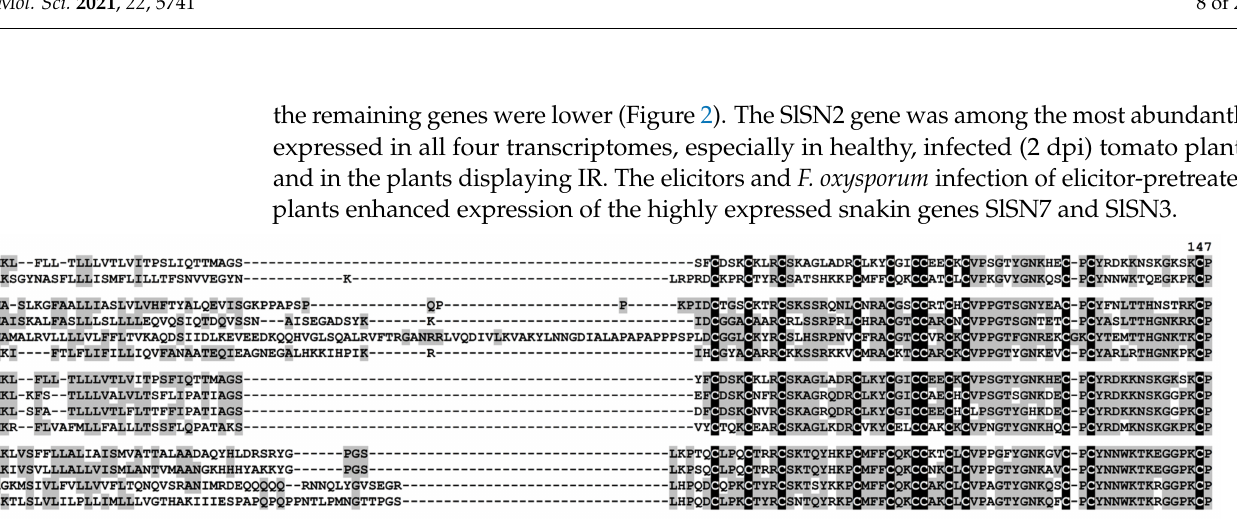
Figure 5. Multiple sequence alignment of S. lycopersicum snakin precursors and Solanum tuberosum SN1 (Q948Z4.1). Cysteine residues are shaded black, and identical amino acids are shaded gray.